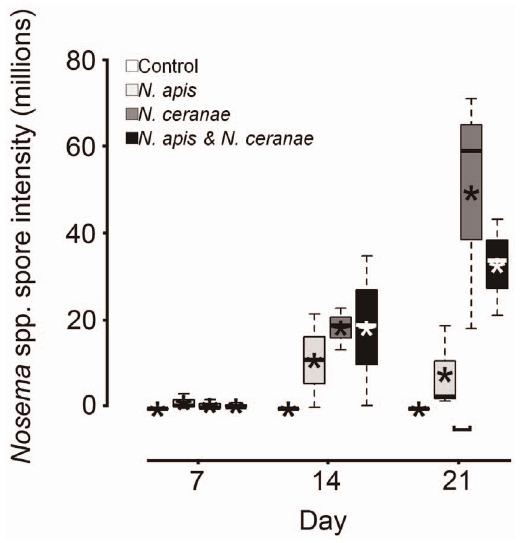
Figure 5. Nosema infection intensities in live-sampled adult worker western honey bees ( Apismellifera ) at 7, 14, and 21 d post oral inoculation in control, Nosemaapis , Nosemaceranae , and mixed N. apis / N. ceranae treatments. Boxplots show inter- quartile range (box), median (black or white line within interquartile range), data range (dashed vertical lines), and outliers (open dots); asterisks (black or white) represent means. Horizontal square paren- thesis under boxplots indicates a significant difference; controls were excluded from analyses because no infections were observed.